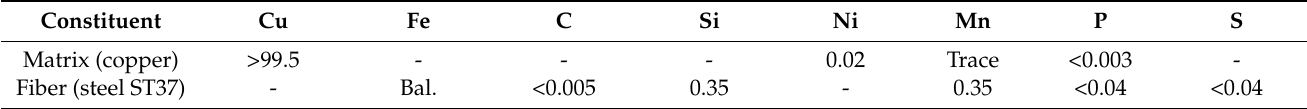
Table 1. Typical chemical compositions of the copper matrix and the mild steel rod (in wt.%).